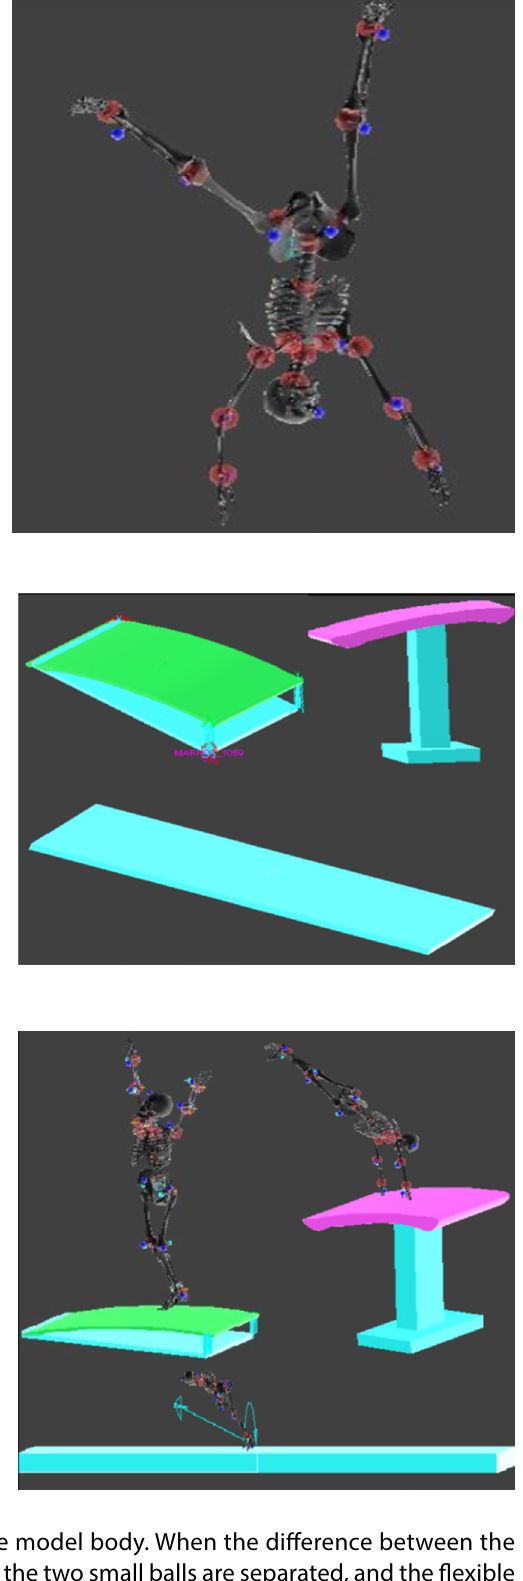
Fig. 6 Initial pose of the human body model after bal- ance analysis